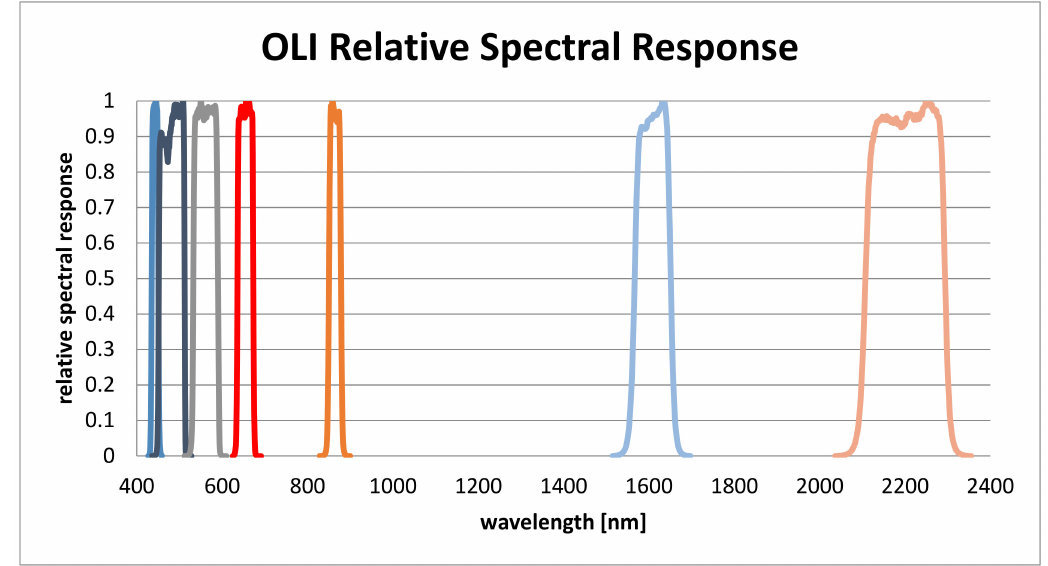
Figure 9. Relative spectral response of Landsat8 OLI (CA-SWIR2)